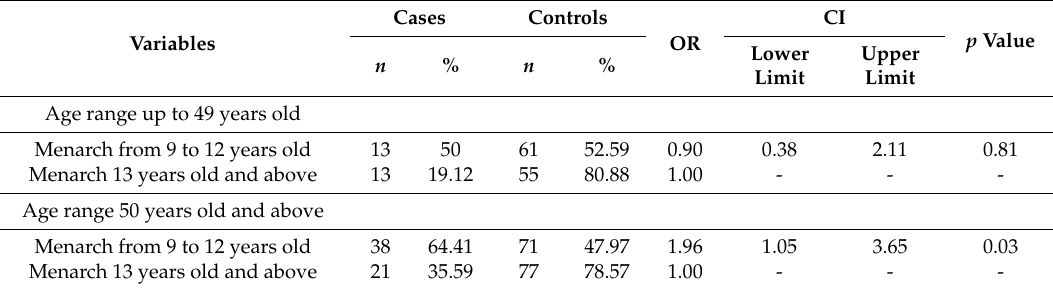
Table 4. Stratified analysis by age and breast cancer, Rondon ó polis-MT, November 2017 to April 2018. Variables